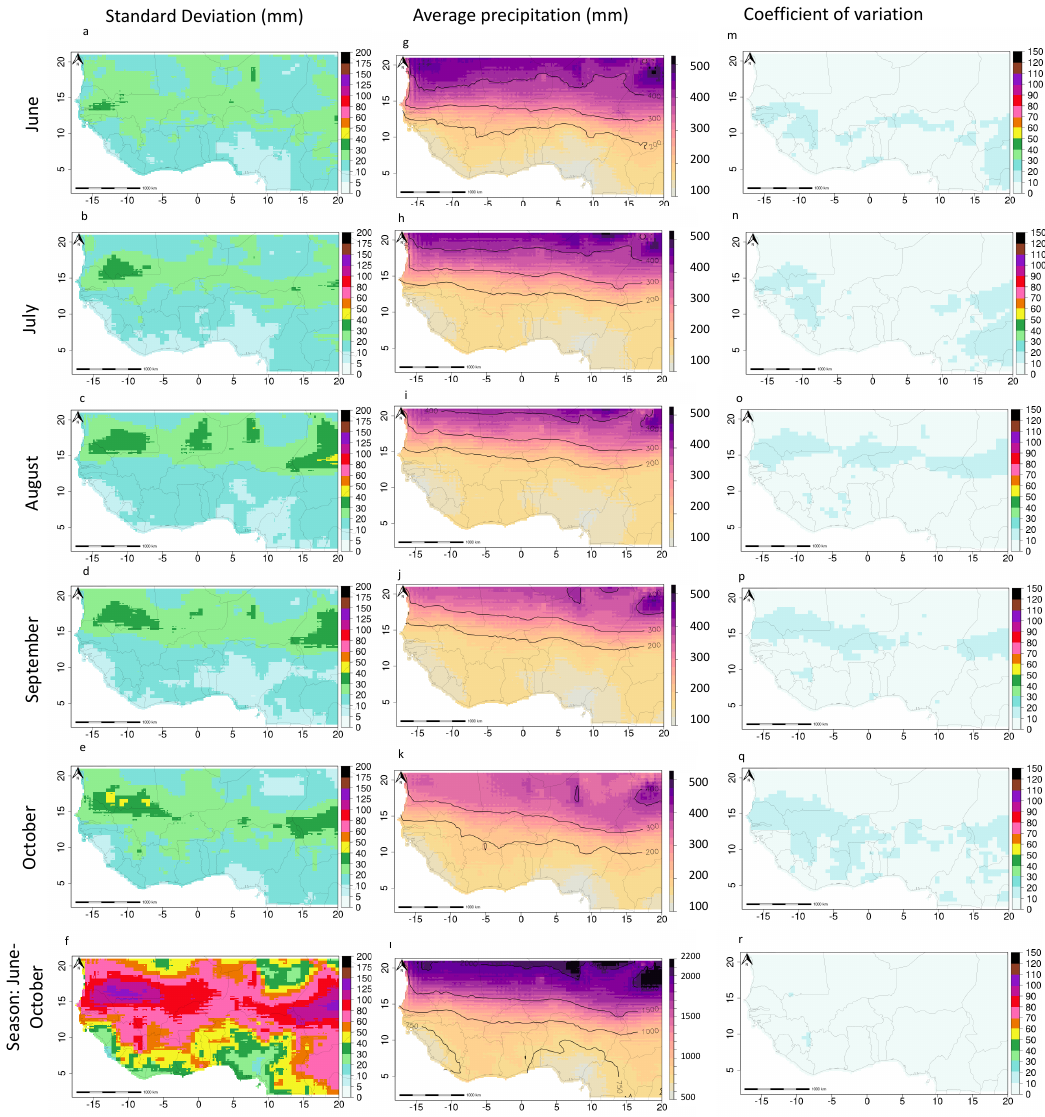
Figure A2. These three columns show the variability for ET 0 from 1981 to 2016. The right-hand column ( a – f ) has the standard deviation by month as expressed in mm/month (seasonal is mm/season), June ( a ), July ( b ), August ( c ), September ( d ), October ( e ), and the whole season ( f ) for 1981–2016. The middle column ( g – l )shows the average ET 0 per month (expressed in mm/month or mm/season for l for June ( g ), July ( h ), August ( i ), September ( j ), October ( k ), and the whole season ( l ). The left-hand column ( m – r ) has the coefficient of variation per month expressed in percentages for June ( m ), July ( n ), August ( o ), September ( p ), October ( q ), and the whole year ( r